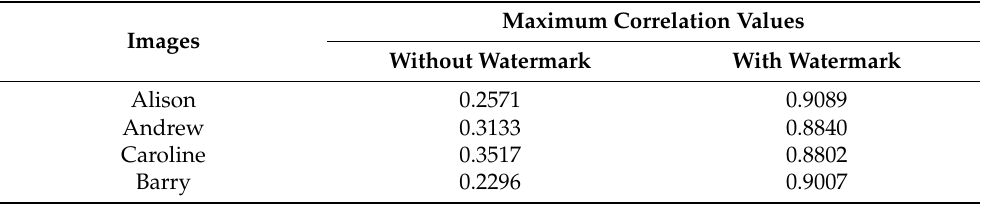
Table 3. The correlation values of images before and after the insertion